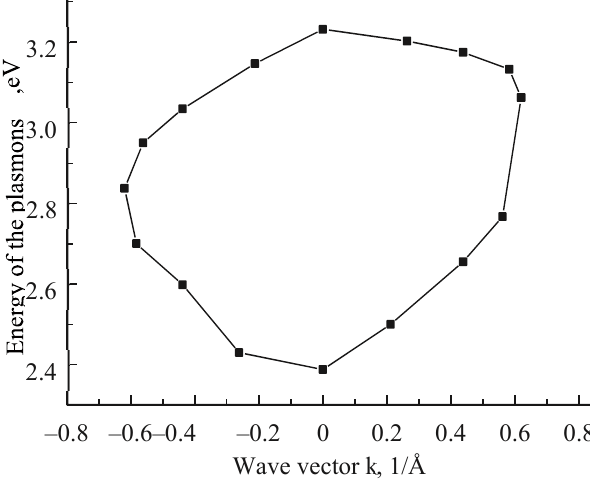
Figure 5. Dispersion of surface plasmons for fused quartz [34].